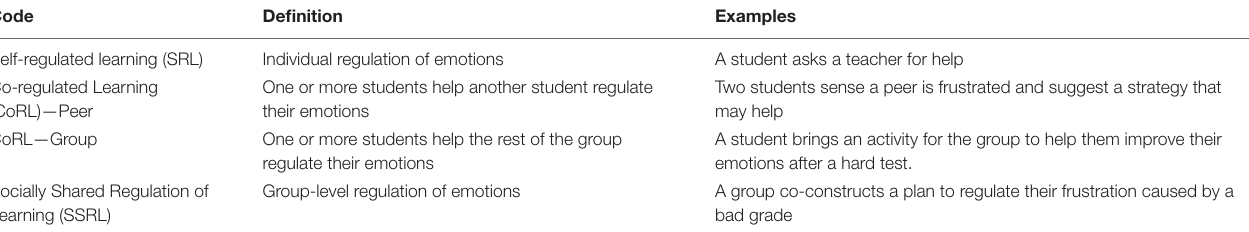
TABLE 7 | Regulation